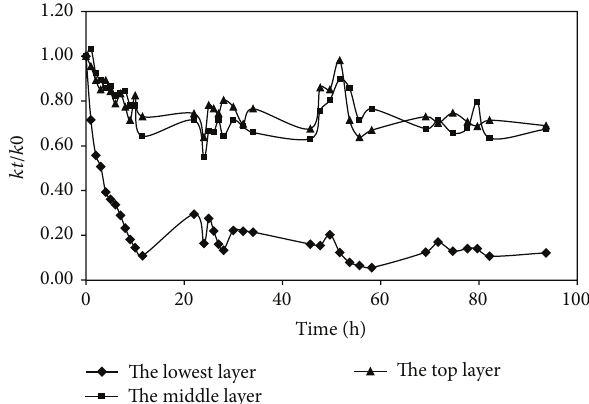
Figure 7: Relationship between 𝑘𝑡/𝑘0 and time in different layers under the hydraulic gradient of 1.25 (experiment 1).